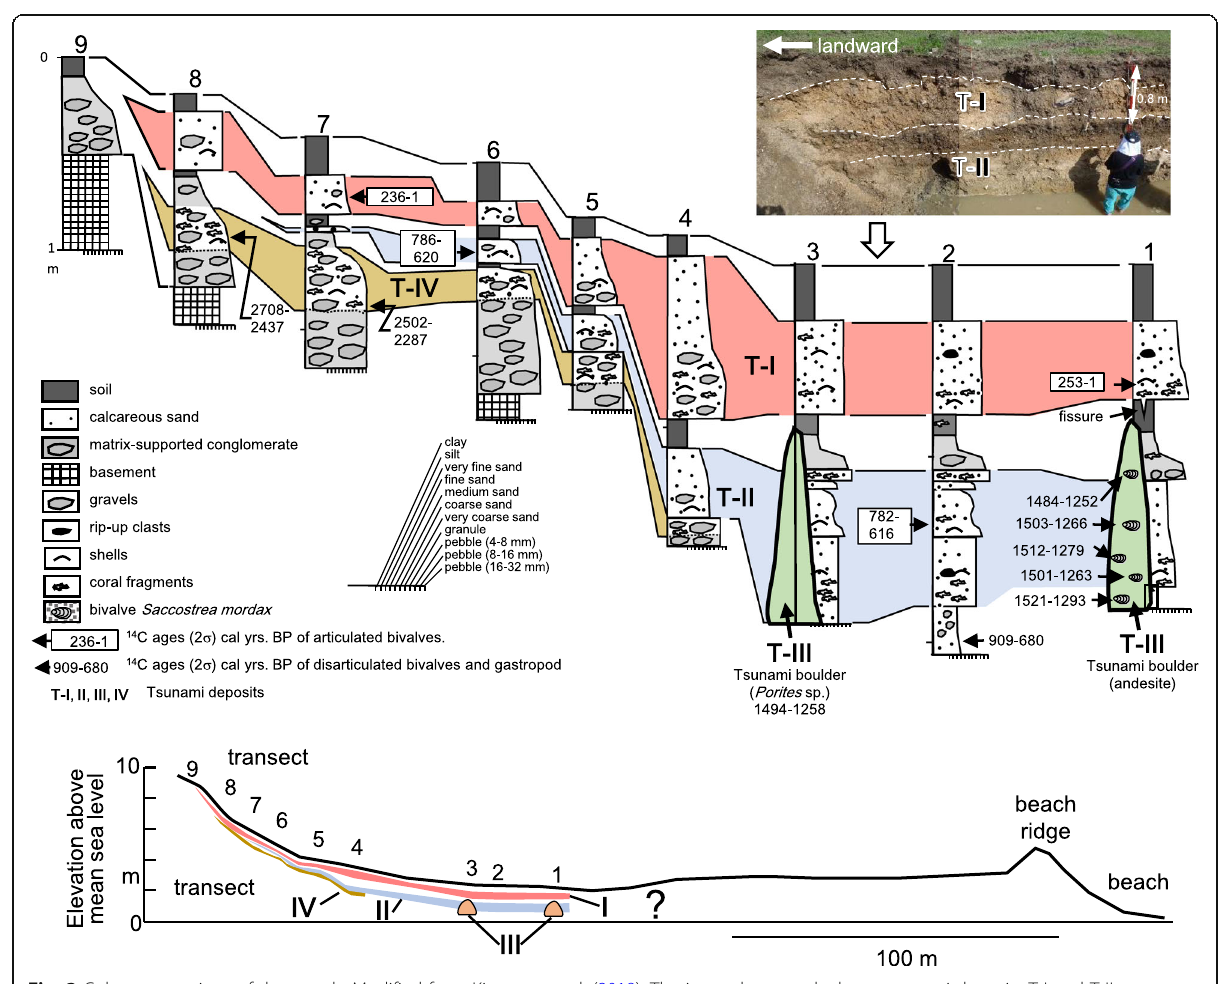
Fig. 3 Columnar sections of the trench. Modified from Kitamura et al. (2018). The inset photograph shows tsunami deposits T-I and